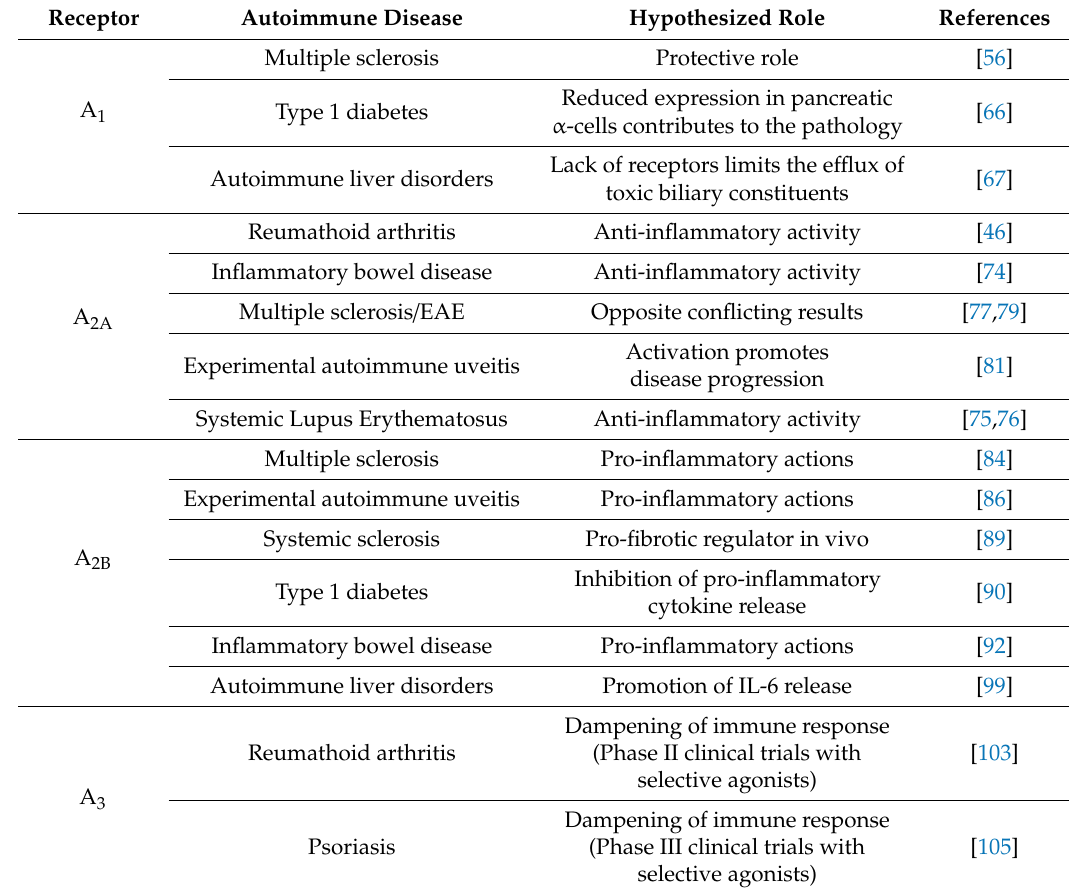
Table 1. Overview of the involvement of ARs in various autoimmune